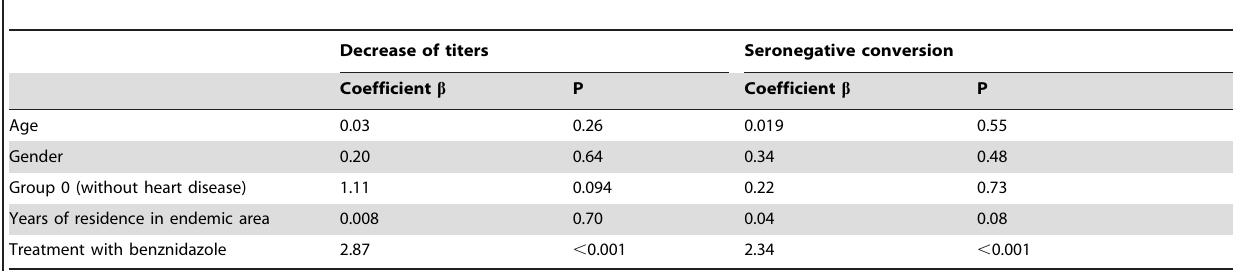
Table 2. Logistic regression for decrease of titers and seronegative conversion on conventional serological assays in T.cruzi - infected